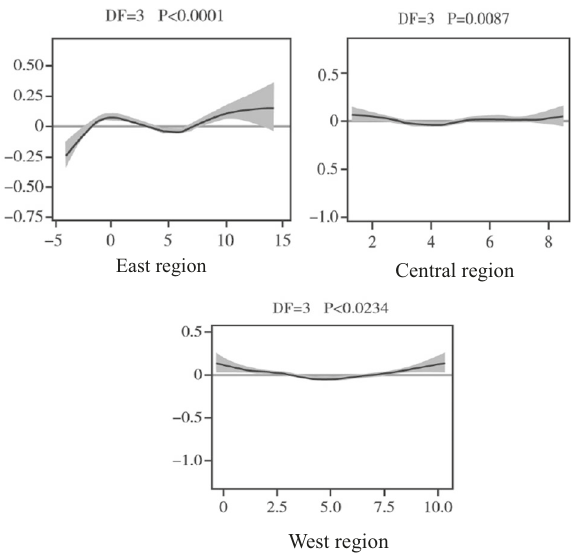
Fig. 2 The nonlinear impact of CED on CDE in three regions. The nonlinear impact of CED on CDE shows an “ M-shape ” curve in the eastern region. The nonlinear impact of CED on CDE shows a gentle “ W-shape ” curve in the central region. The nonlinear impact of CED on CDE shows a “ U- shaped ” curve in the western